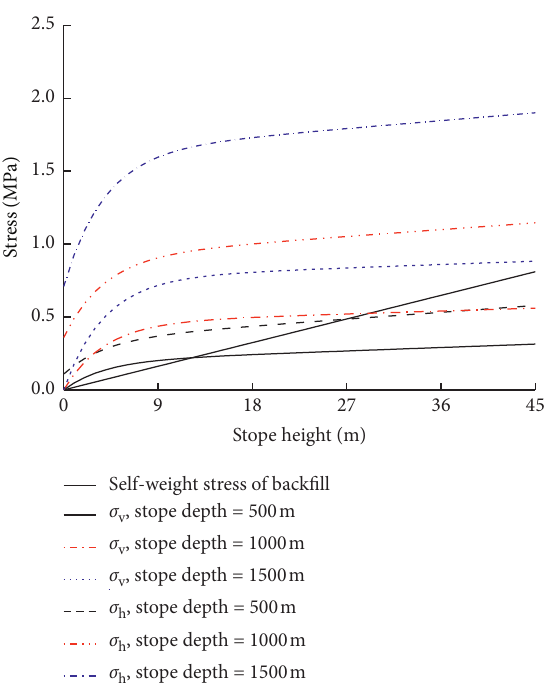
Figure 16: Elastic modulus effect on the time-dependent stress distribution of backfilling.